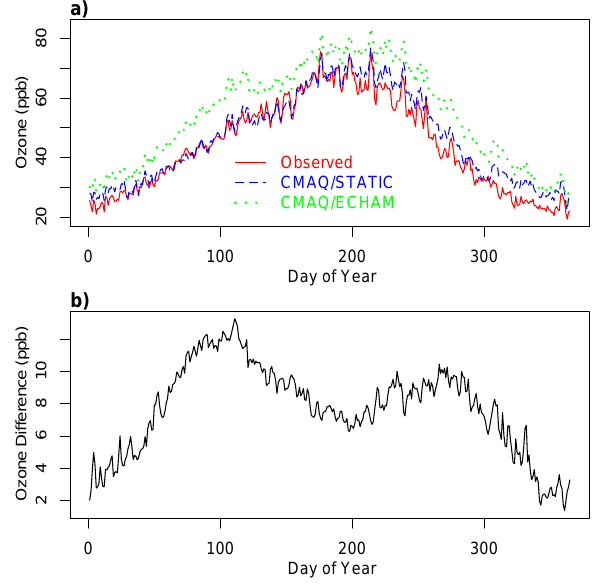
Fig. 12. Seasonal cycle of daily maximum 1-h ozone concentrations averaged over 1988–2005 and all 90 monitors in the 12km CMAQ domain. (a) observations, CMAQ/STATIC, and CMAQ/ECHAM5- MOZART concentrations. (b) differences between CMAQ/STATIC and CMAQ/ECHAM5-MOZART